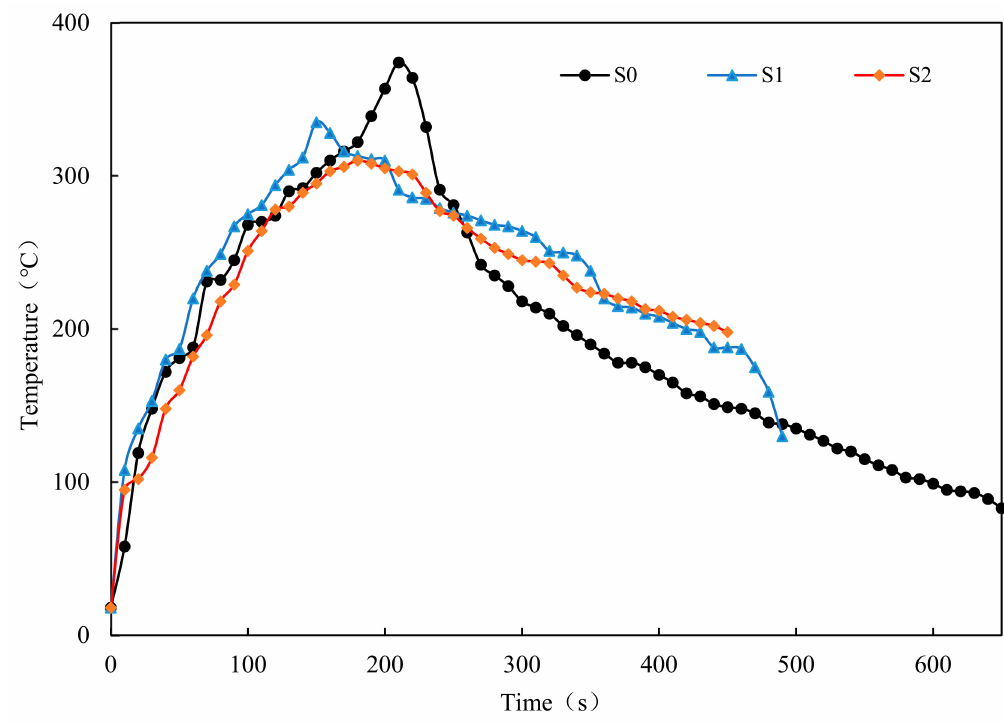
Figure 11. The temperature vs. time of different loose mixtures. Table 7. Combustion duration and maximum temperature of different loose